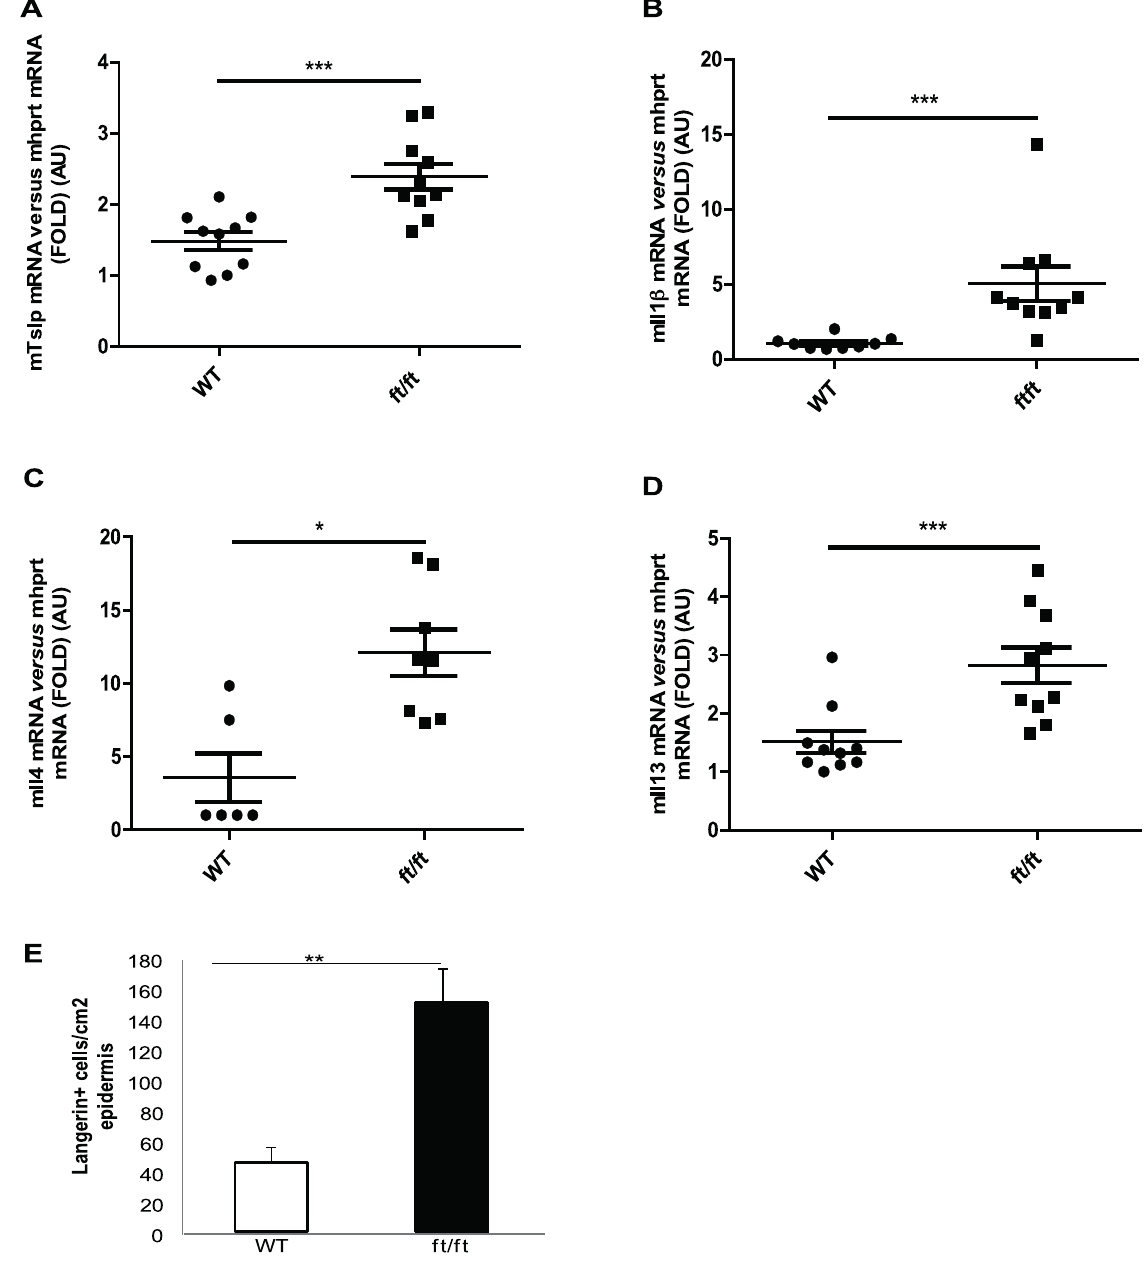
Figure 2. Analysis of proinflammatory and Th2-derived cytokines in a/amaft/maft/J mouse skin. Total RNAs were extracted from dorsal skin of P5 WT and a/a ma ft/ma ft/J (ft/ft) mice, and cDNAs were generated. Real-time PCRs were performed using primers specific for ( A ) Tslp , ( B ) Il1 b , ( C ) Il4 and ( D ) Il13 . Ct values were normalized with the hprt house-keeping gene. The experiment was realized in groups of 10 mice. (E) Langerin positive cells stained in WT and a/a ma ft/ma ft/J (ft/ft) mice skin biopsies were quantified. Statistically significant differences were calculated with the student T-test (p , 0.05 * and p , 0.001 ***).